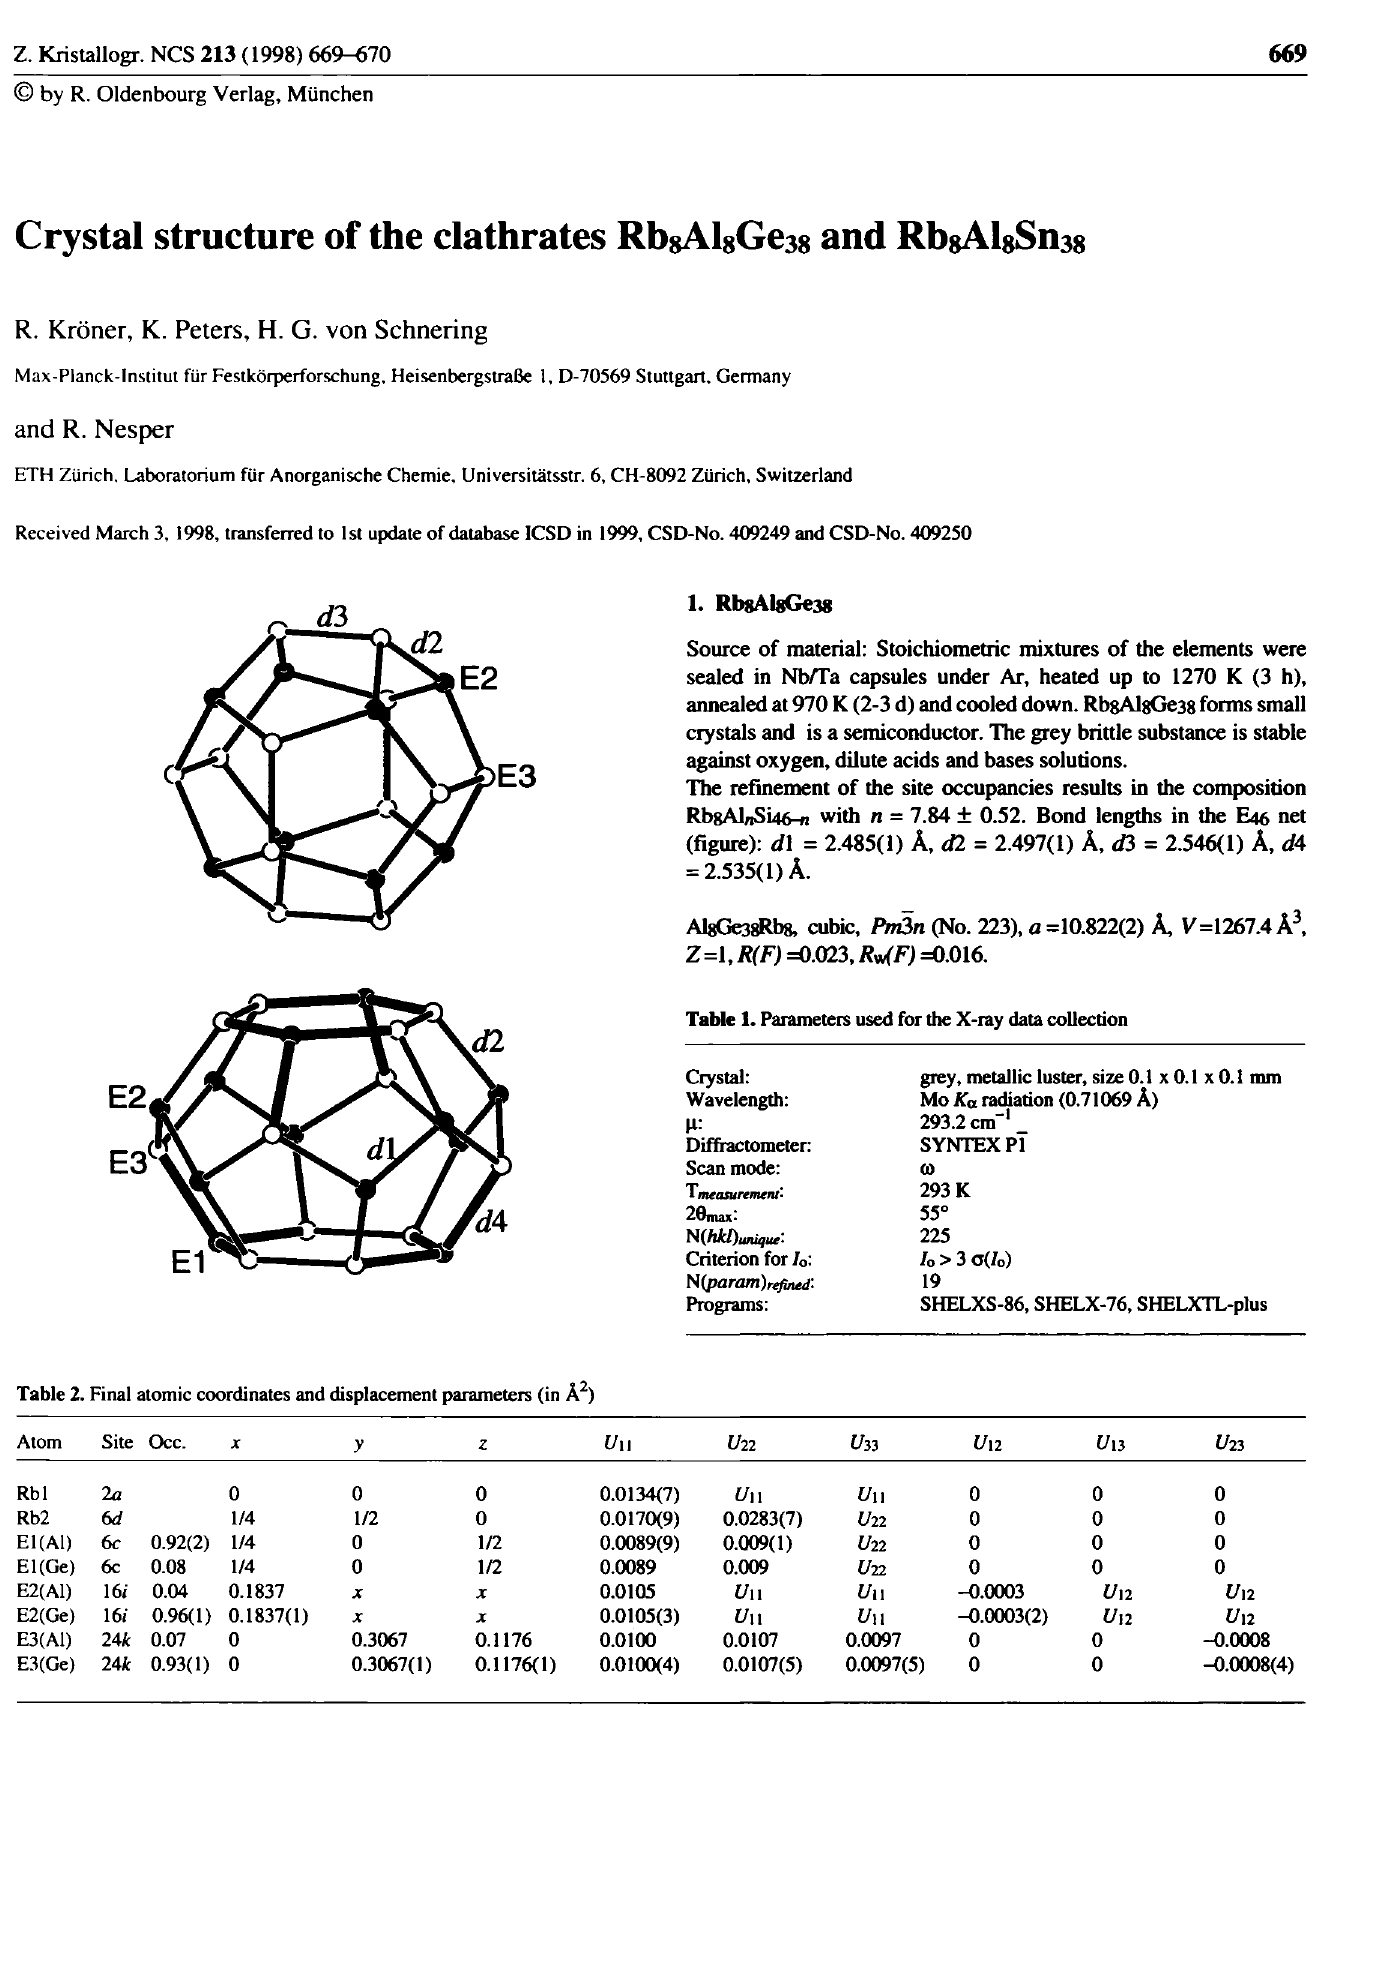
Table 2. Final atomic coordinates and displacement parameters (in Â^) Atom Site